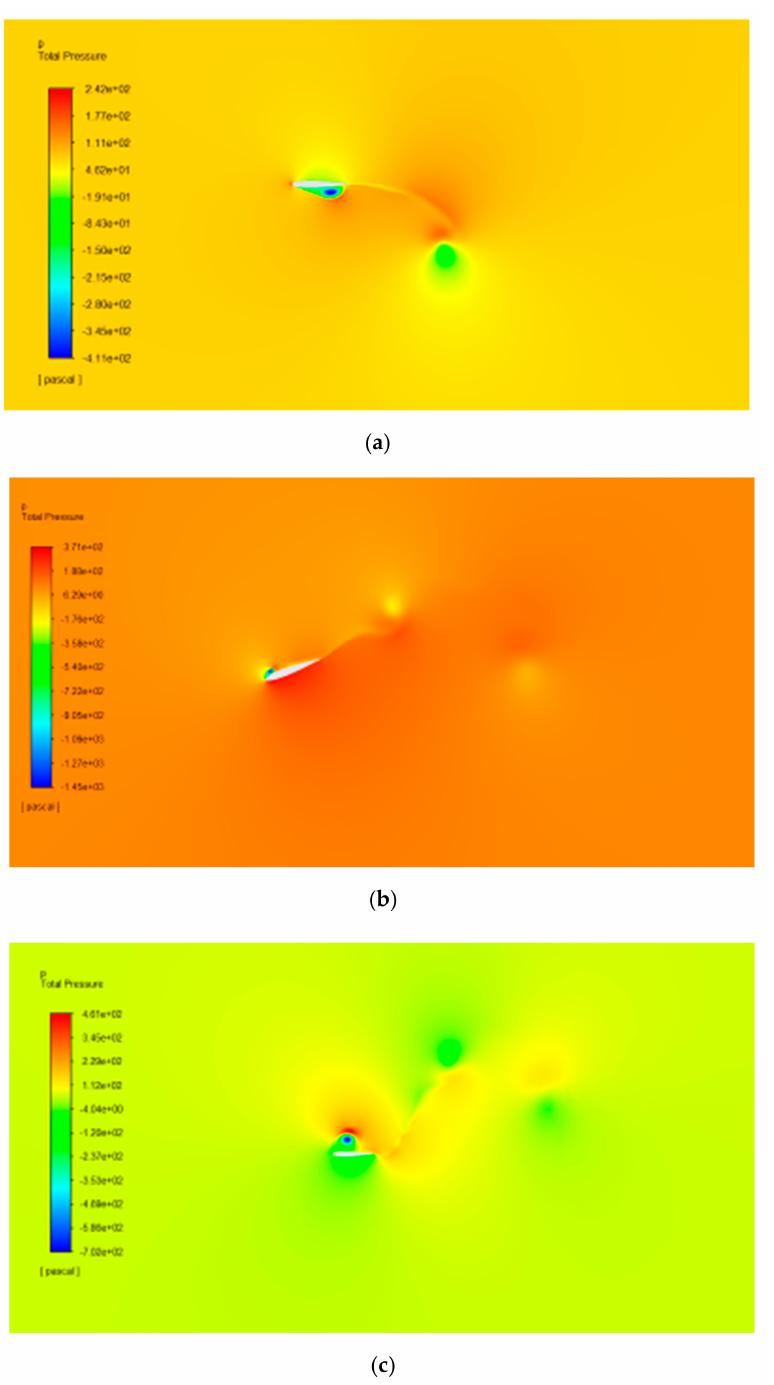
Figure 7. Pressure contour at different times (The left side is the pressure contour; the right side is the velocity contour) ( a ) t = 0.25 T ( b ) t = 0.5 T ( c ) t = 0.75